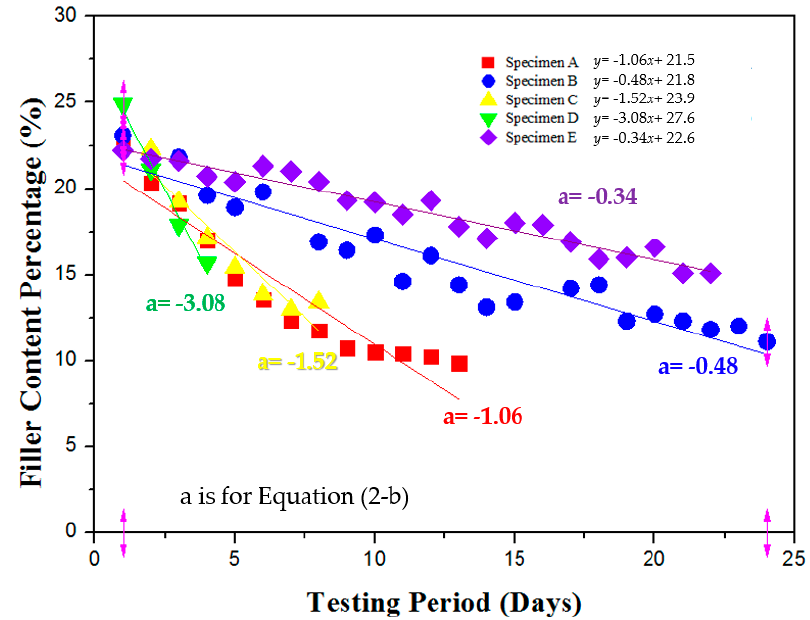
Figure 10. Filler content settlement rate linear regression analysis of ENC-SPRG.